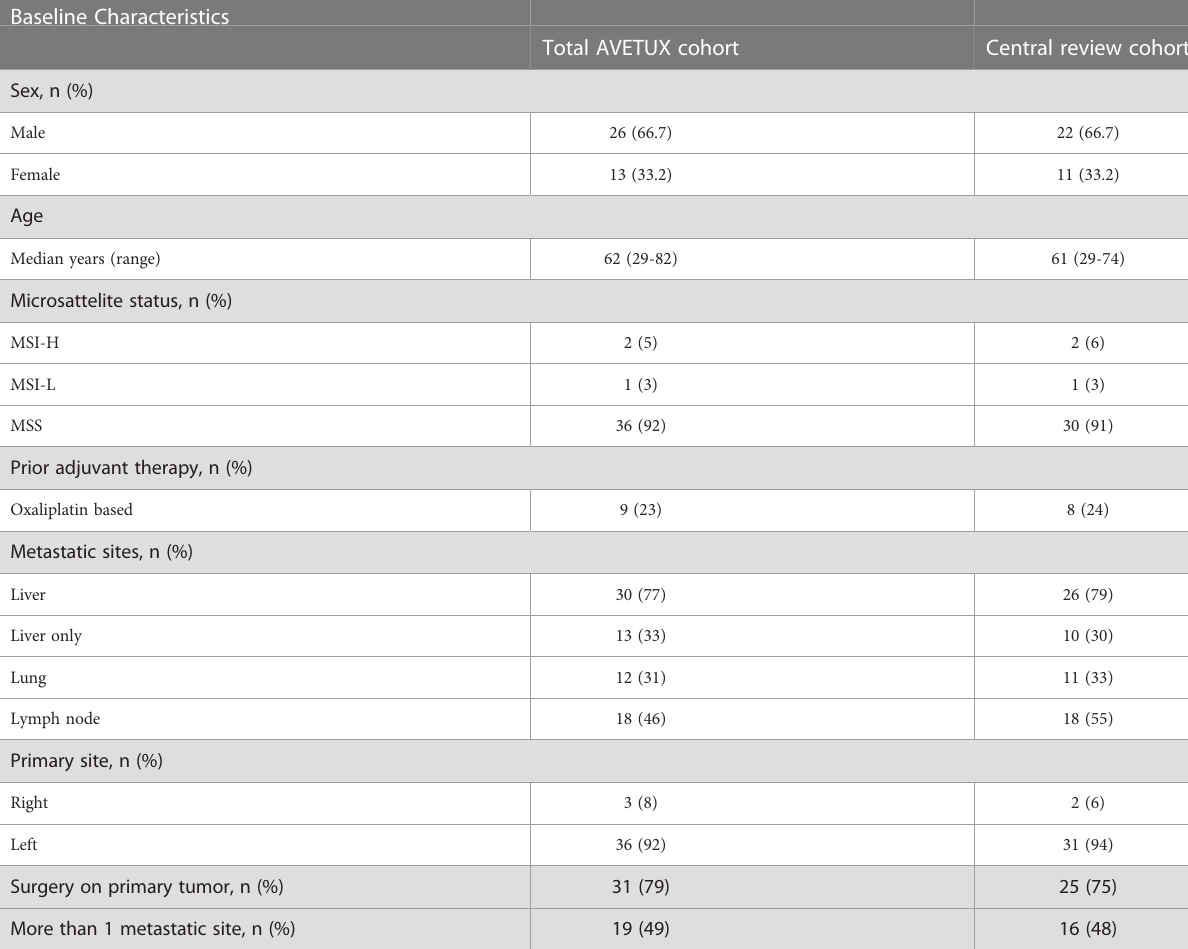
TABLE 1 Patient characteristics of the response evaluated AVETUX cohort and the central review cohort. Baseline